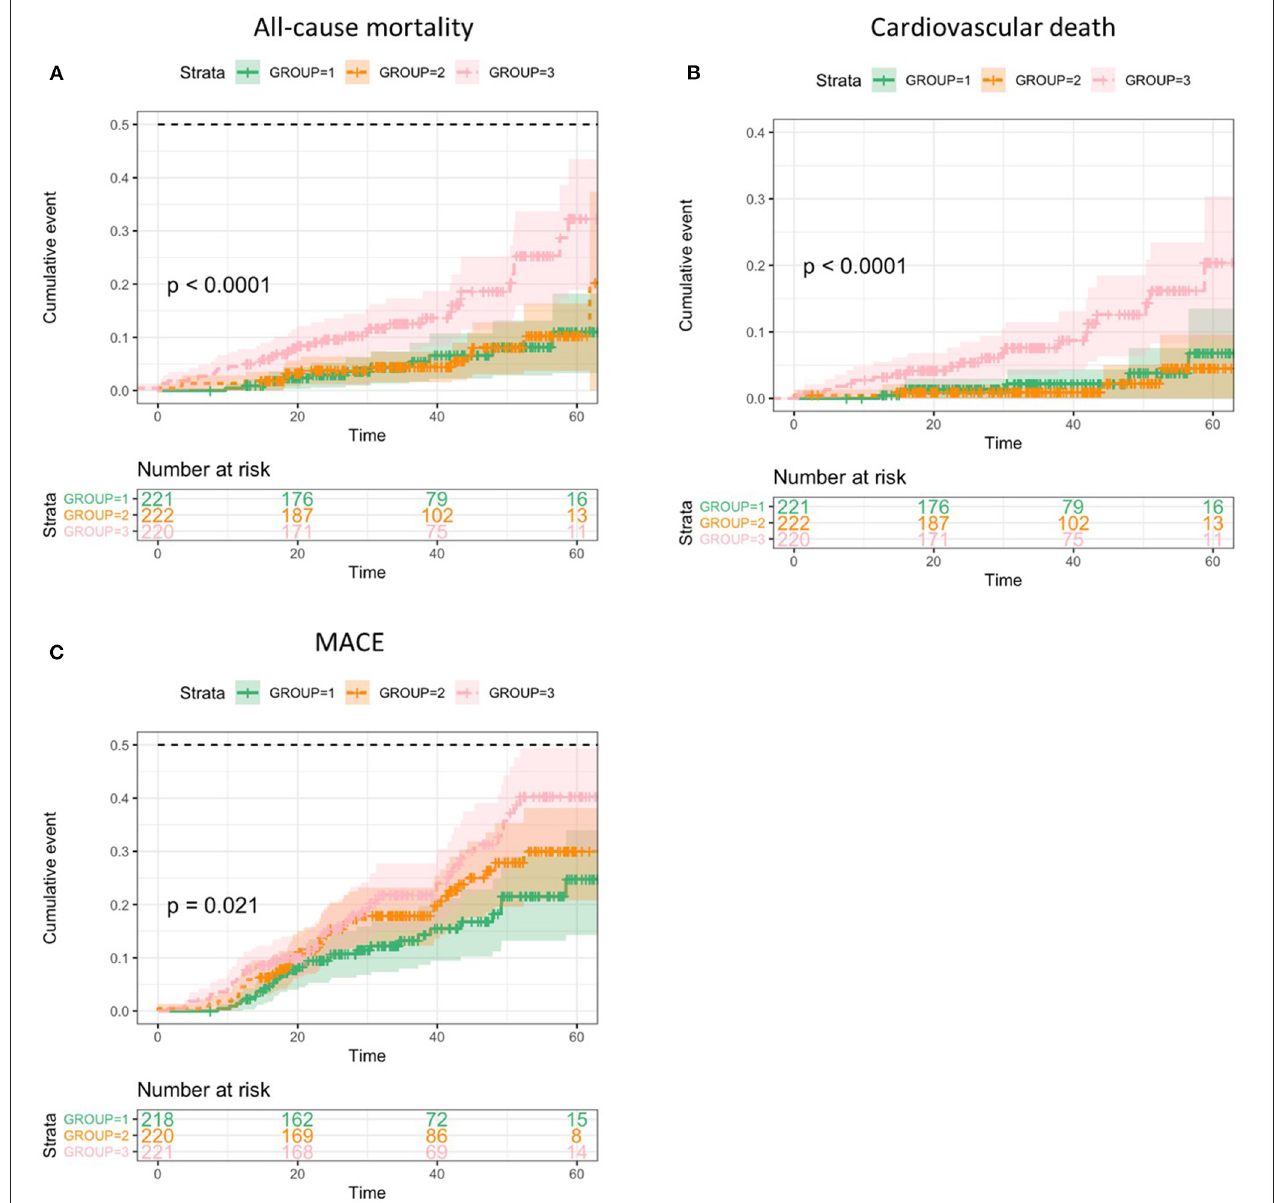
FIGURE 2 | Kaplan-Meier analyses of clinical outcomes categorized by C-reactive protein to albumin ratio (CAR) values. (A) , All-cause death. (B) , Cardiovascular death. (C) , Major adverse cardiovascular events (MACE).